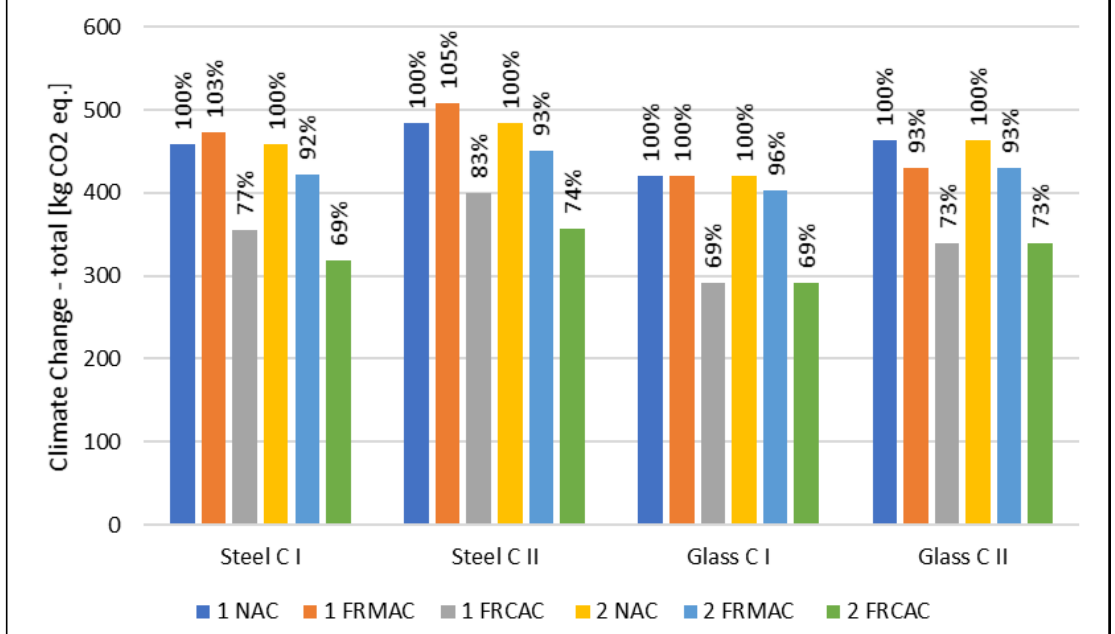
Table 8. Normalized and weighted results (EF 3.0) and differences −Δ (%) of serviceability (SA).